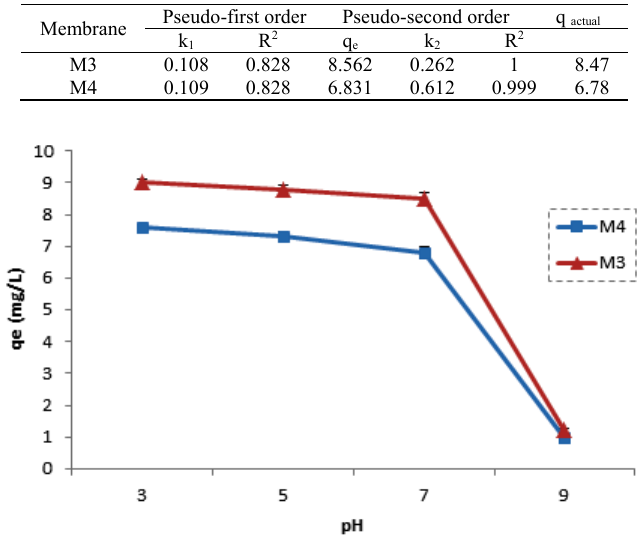
Fig. 7. The effect of solution pH on HA adsorption capacity for M3 and